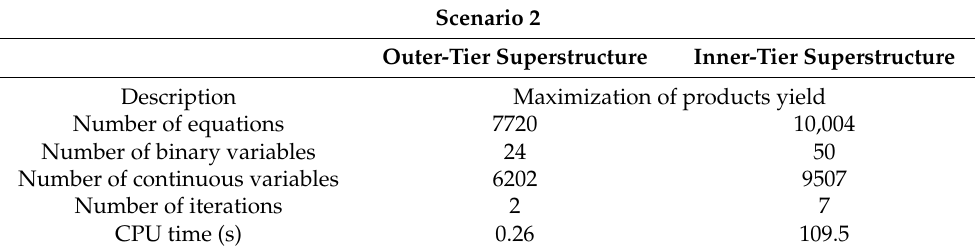
Table 4. Calculation time of the optimal biorefinery configuration of Scenario